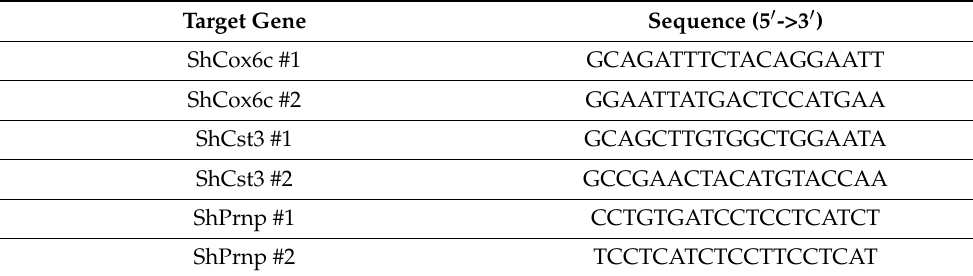
Table 2. Short hairpin RNA